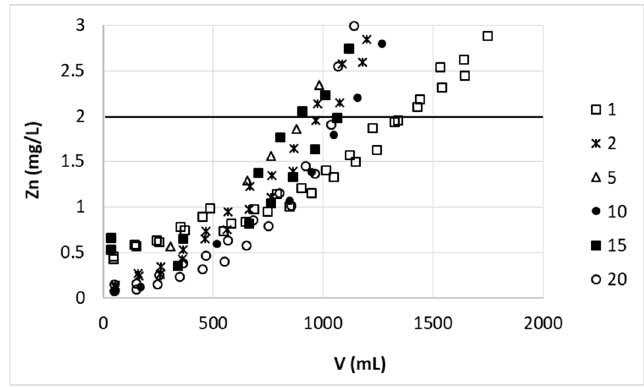
Figure 8. Effect of sorption–desorption cycle number on zinc(II) ions removal on hybrid pectin-based biosorbent. Mass of sorbent (dry form, large grain): 5 g (initially 11.2 cm); flow rate: 60 mL/h; initial concentration of Zn: 30 mg/L; pH = 6.